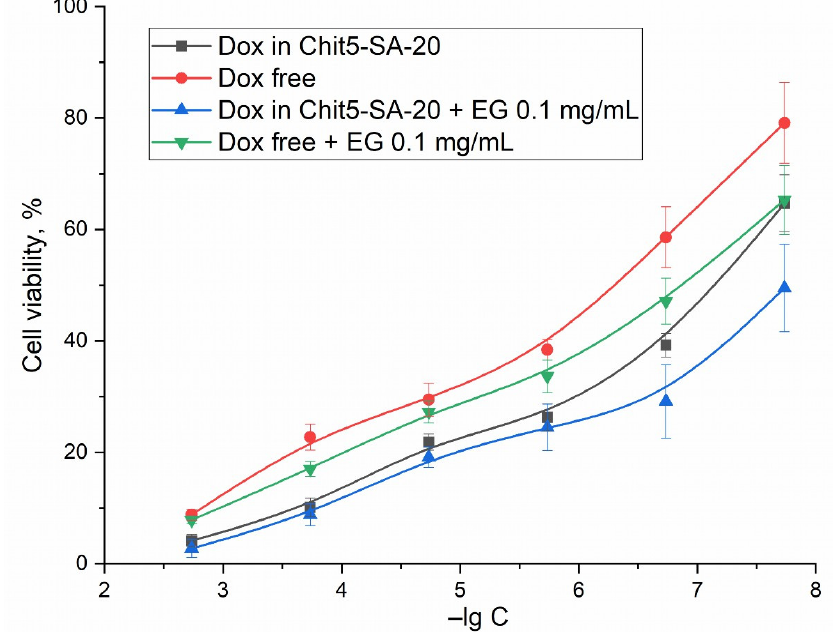
Figure 13. Dependences of A549 cells survival on the logarithm of concentrations of free Dox, Dox in micelles, and Dox enhanced with EG. RPMI-1640 medium supplemented with 5% fetal bovine serum and 1% sodium pyruvate at 5% CO 2 /95% air in a humidified atmosphere at 37